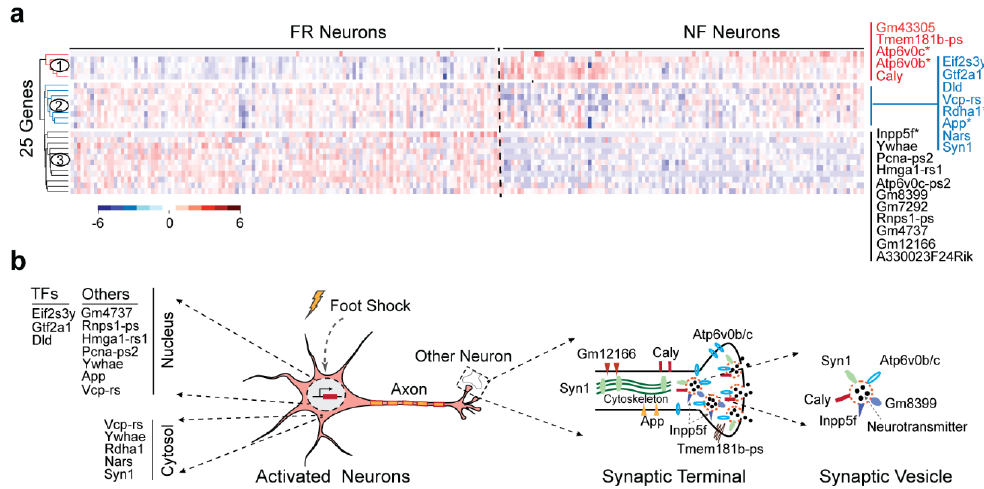
Figure 4. Expression heatmap and cellular locations of 25 fear-memory-related genes. ( a ) Heatmap of 25 genes detected by DEGman in the first cell cluster. Three gene groups are detected by hierarchical clustering analysis. * denotes the genes previously reported in RA-DEGs. ( b ) Illustration of gene locations. TF: transcriptional factor.